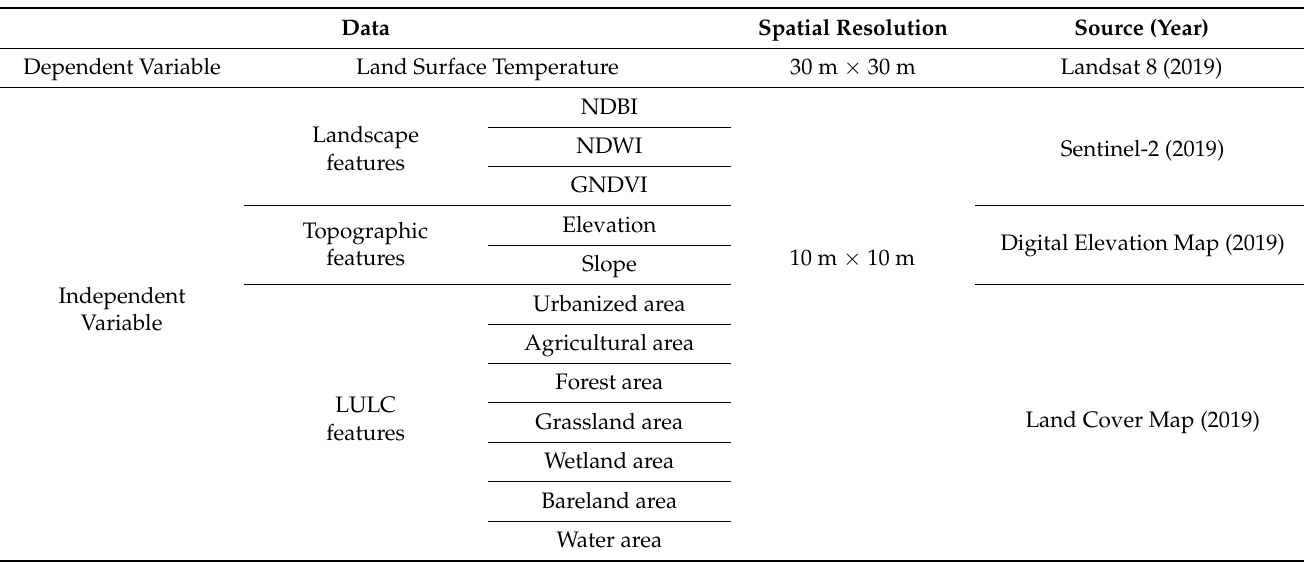
Table 1. Variables used in the